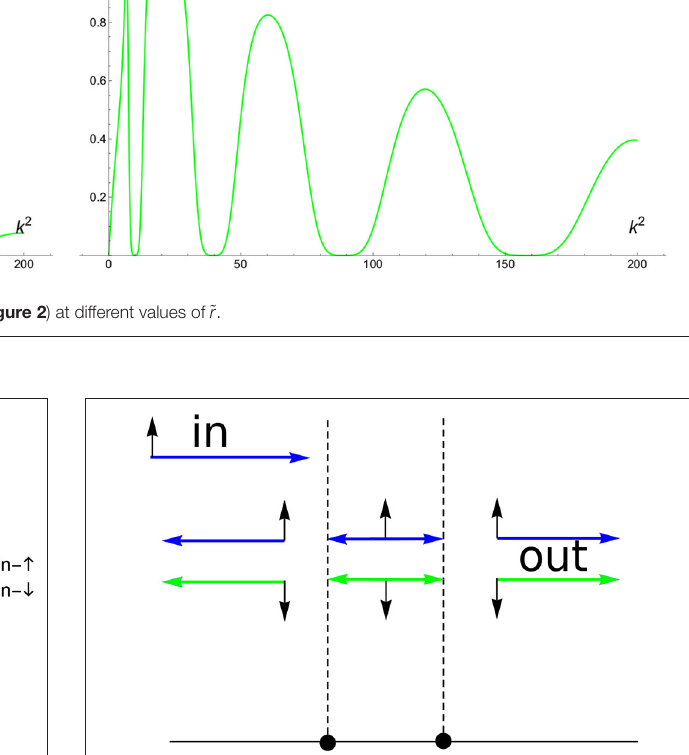
FIGURE 6 | Filter.